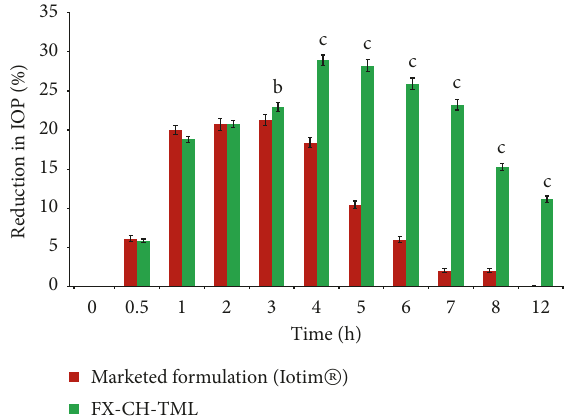
Figure 8: Percentage reduction in IOP (%) after administration of FX-CH-TML nanoparticles and marketed formulation ( ∗∗ b = P < 0.01 ; c = P < 0.001